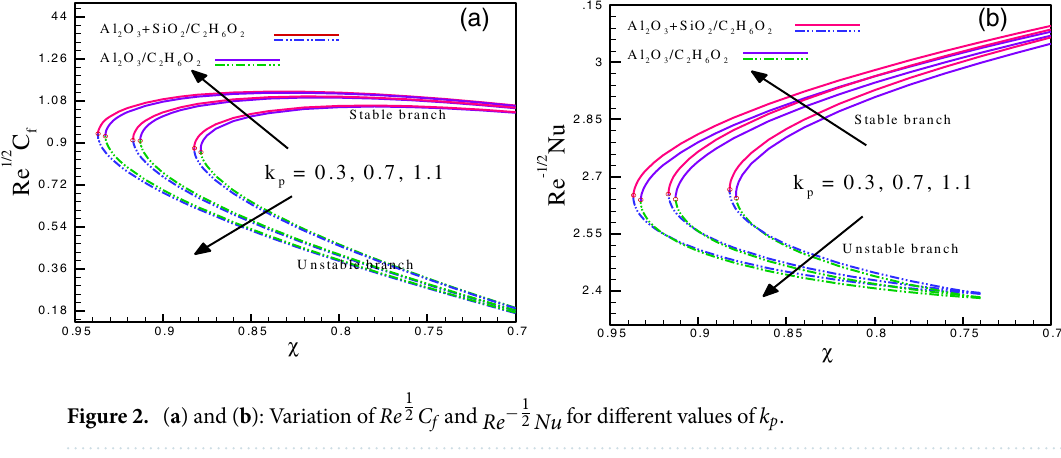
Figure 2. ( a ) and ( b ): Variation of Re